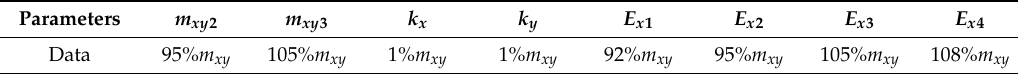
Table A10. The membership function parameters of the baseline load and the price elastic coe ffi